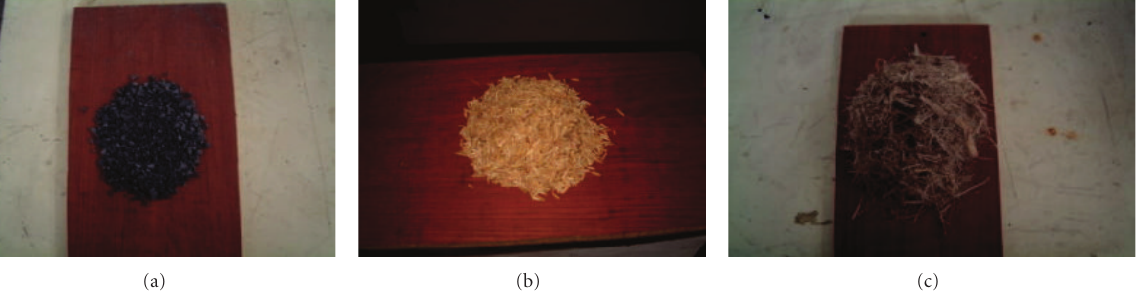
Figure 1: fuel physical (a) lignite, (b) rice husk, and (c) bagasse.